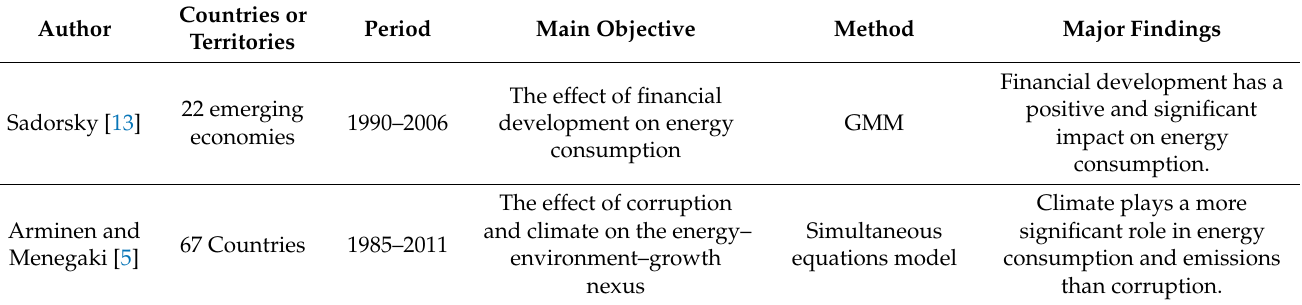
Table 1. Selected empirical literature on the relationship between energy and electricity consumption and their